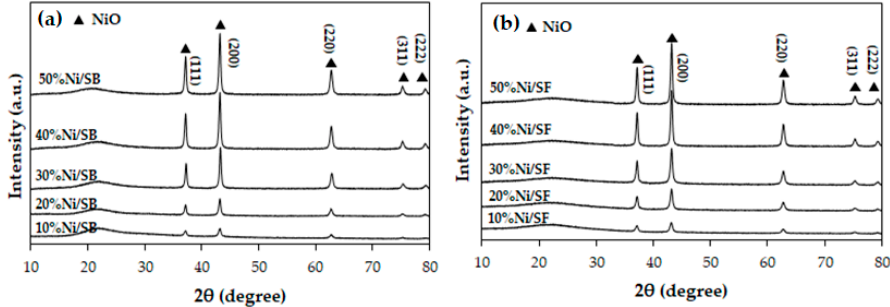
Figure 2. XRD patterns of ( a ) Ni/SB and ( b ) Ni/SF catalysts containing various contents of Ni loading.